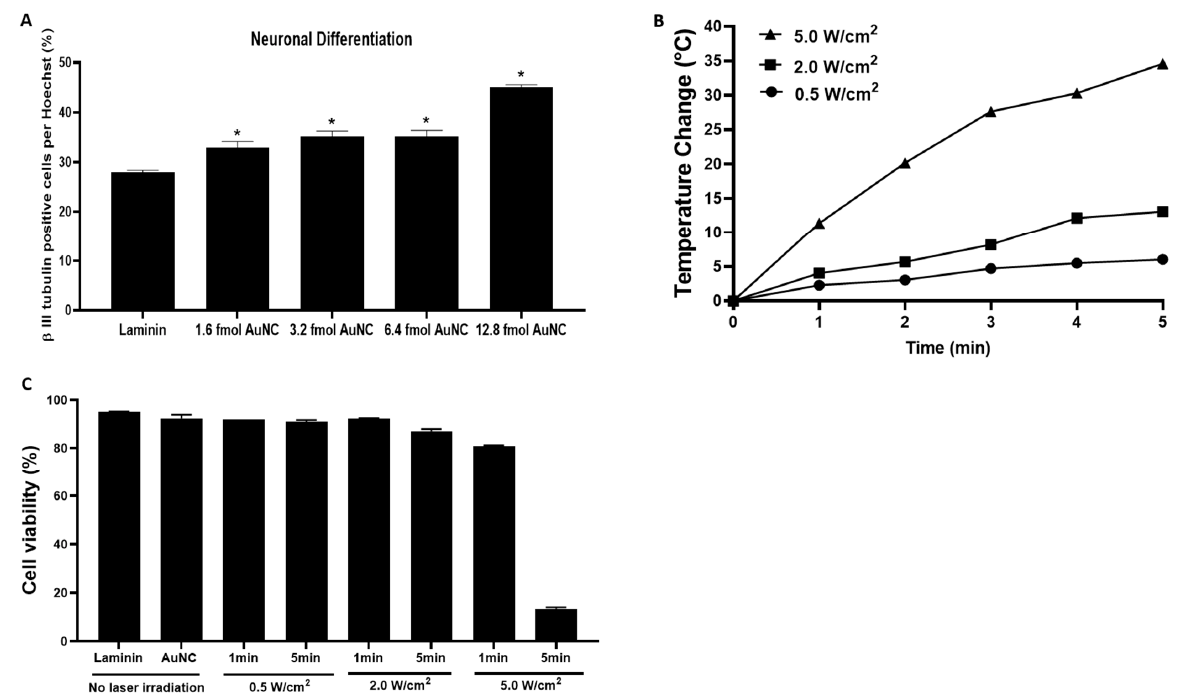
Figure 2. Cell viability and neuronal differentiation of rNSCs grown on laminin-coated AuNC-aECMs with/without laser irradiation. rNSCs were seeded onto laminin-coated AuNC-aECMs with varying coverage densities of AuNCs. Cells were analyzed with immunocytochemistry at 16 days post seeding ( A ). The laminin-coated AuNC-aECMs were treated by laser irradiation with varying parameters (0.5–5.0 W/cm 2 for 1–5 min), and the temperature at the surface in wells containing 1 mL cell culture medium was measured by a thermocouple ( B ). rNSCs were seeded onto laminin-coated AuNC-aECMs, and after 4 days, the cells were treated with indicated laser irradiation (0.5–5.0 W/cm 2 for 1–5 min). After 24 h, the cells were collected, and then, cell viability assay was performed using flow cytometry ( C ). Values represent the means ± SDs of three independent experiments. * p values < 0.05 vs. the control group (laminin-coated glass coverslip).